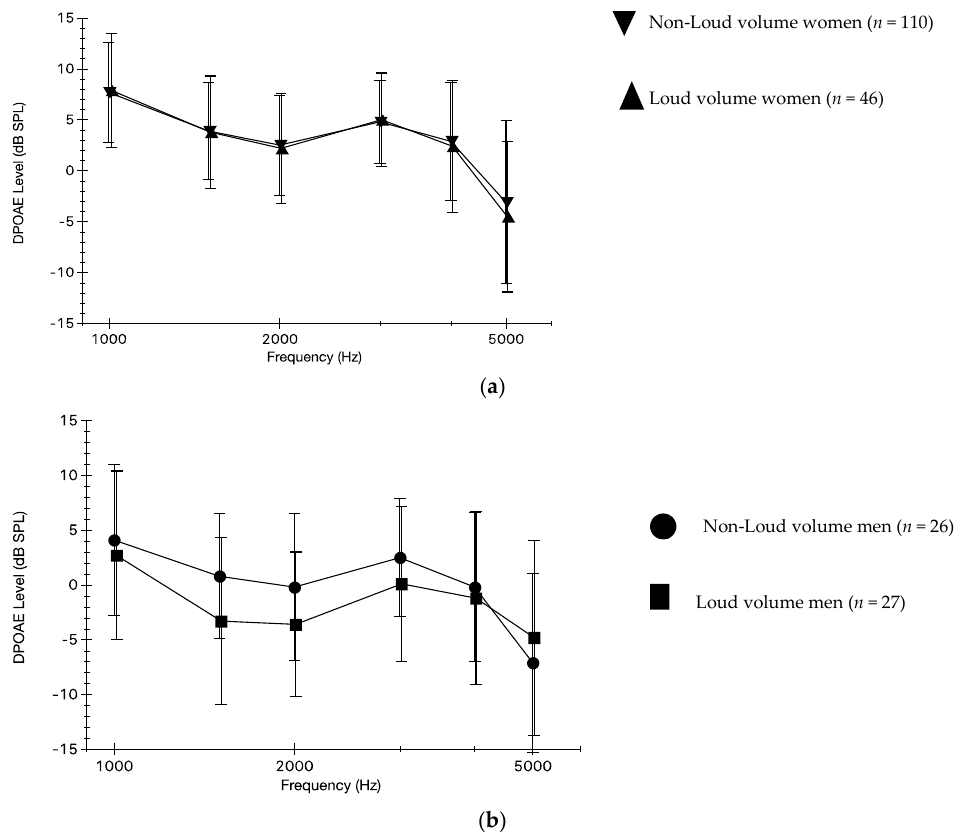
Figure 1. ( a ) The means and standard deviations are shown for DPOAE levels across the frequencies tested in women only by self-reported volume categories; ( b ) The means and standard deviations are shown for DPOAE levels across the frequencies tested in men only by self-reported volume